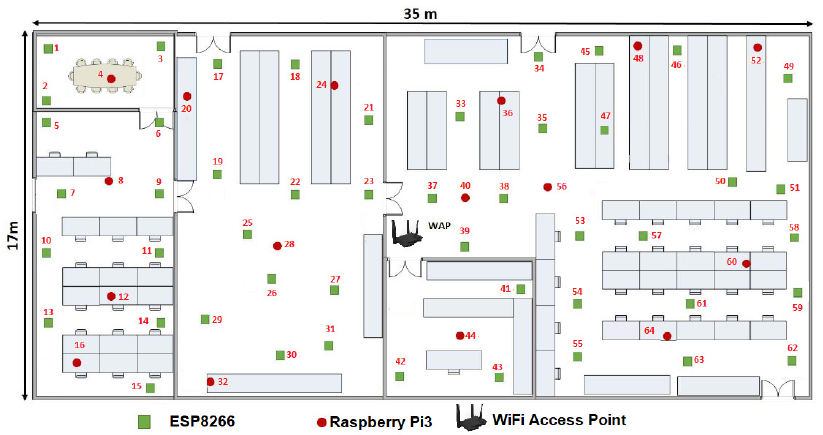
Figure 6. Example of the WSN with swarm intelligence (SI) employed in this